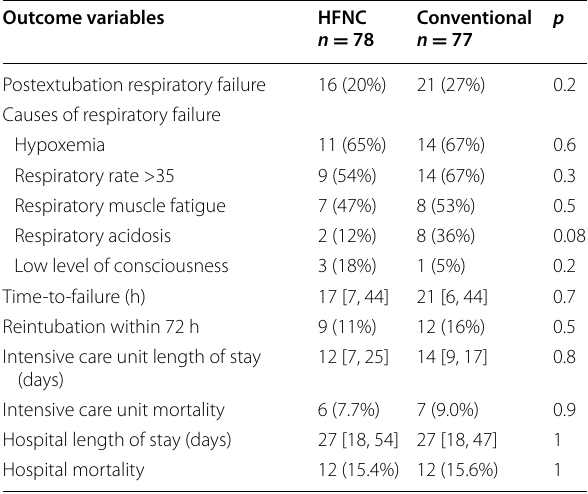
Table 2 Outcome variables in the two